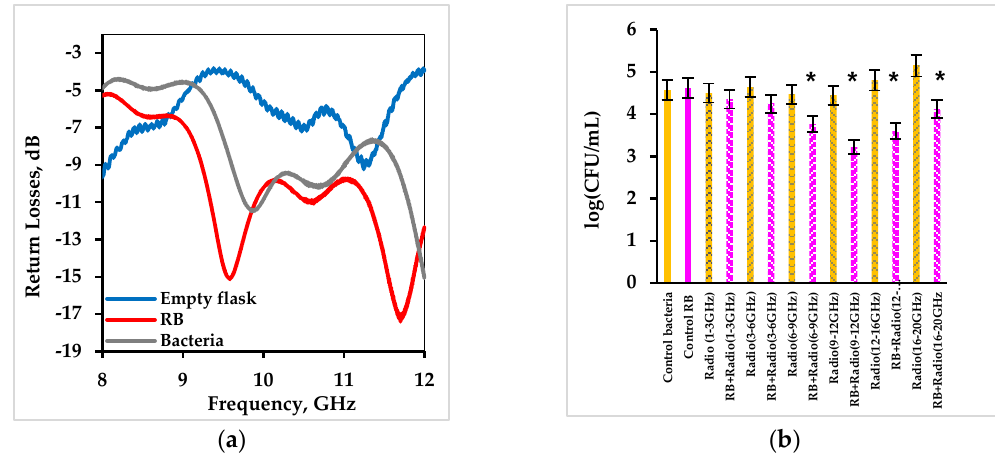
Figure 6. Absorption of radio waves by an empty glass flask, an aqueous solution of Rose Bengal at a concentration of 0.01 mg/mL and a suspension of S. aureus cells at a concentration of 4.4 × 10 4 CFU/mL ( a ) and the effect of Rose Bengal at a concentration of 0.01 mg/mL under activation by radio waves in the dark in the range of 1 – 20 GHz on eradication of S. aureus at an initial cell concentration of 4.4 × 10 4 CFU/mL ( b ). Error bars present standard deviations. The asterisk ( * ) denotes statistically significant differences with the control ( p < 0.05).